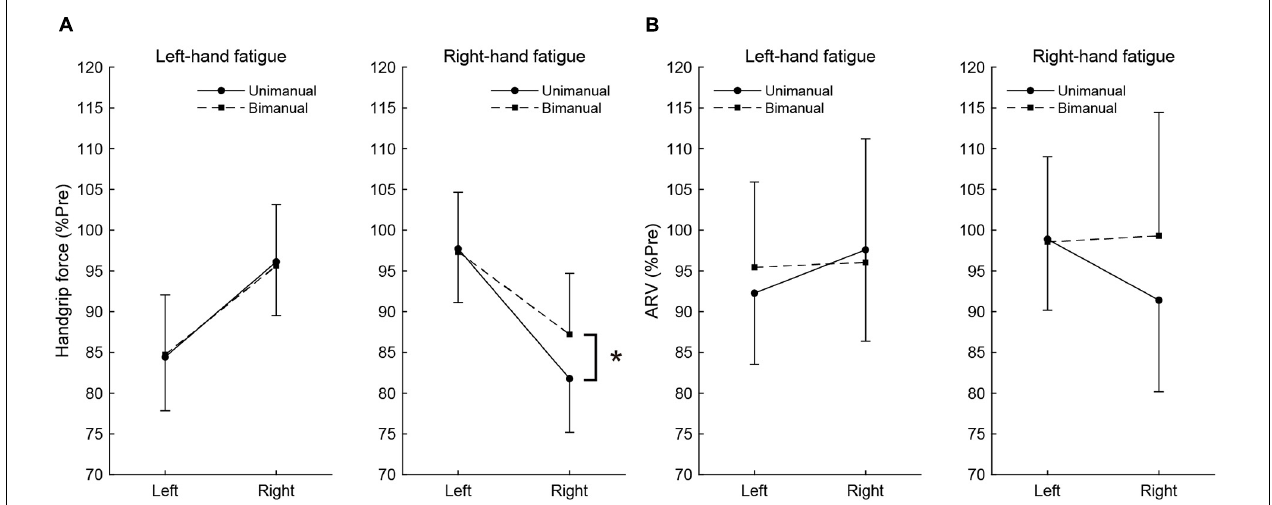
FIGURE 2 | The post-test handgrip force (A) and average rectified value (ARV) of flexor digitorum superficialis (B) , normalized to pre-test. Circles and linear lines indicate unimanual handgrip task, and squares and dashed lines indicate bimanual handgrip task, respectively. Data are presented as mean ± SD. * p < 0.05.